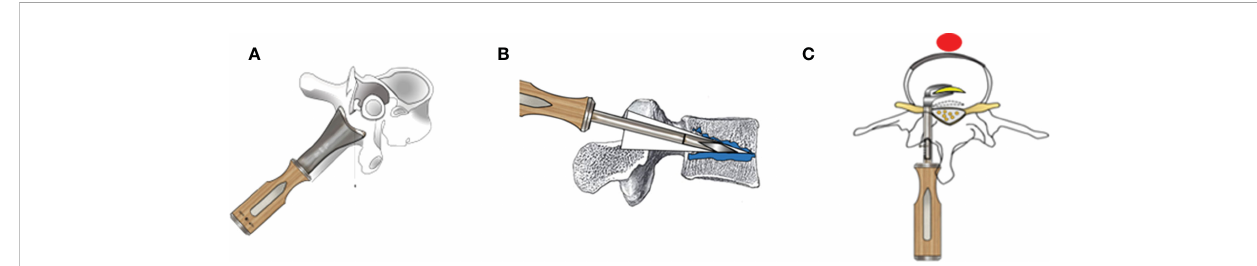
FIGURE 1 The schematic diagram of PSO with the VBCO procedure. (A) The spinous process, ossi fi ed ligamentum fl avum, lamina of intended vertebrae, and bilateral superior and inferior articular processes were removed. (B) An extrusion-type bone osteotome was inserted into the treated pedicle. The wedge-shaped cutting bit was carefully advanced along the pedicle into vertebral body. Then, the osteotome was swung up and down to squeeze surrounding cancellous bone. The fragmented bone was gently compacted toward the fl oor and ceiling, so as to gradually expand capacity among the vertebral body. During this procedure, we took caution to avoid penetration of any vertebral cortices and inferior and superior osseous endplates, and the neural elements should be gently protected. (C) After VBCO, the posterior medial cortex of the wedge space was also resected before closure of the osteotomy